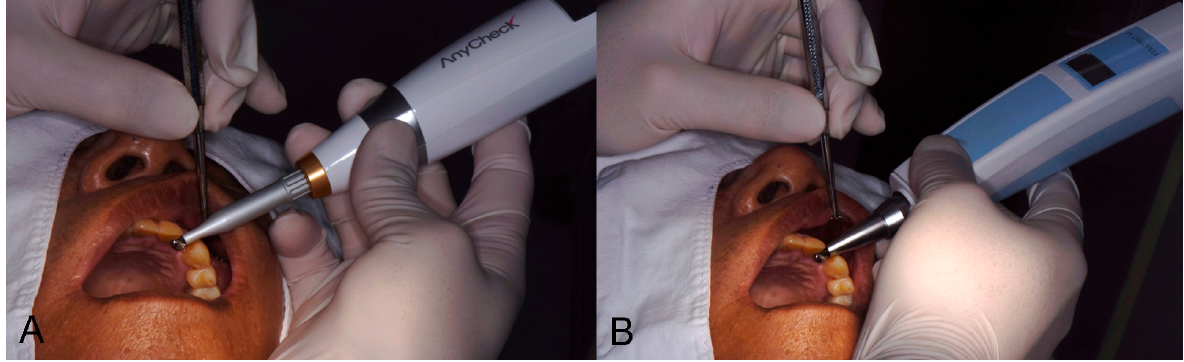
Figure 1. Clinical application of Anycheck and Periotest M equipment. ( A ) Anycheck, ( B ) Periotest M).